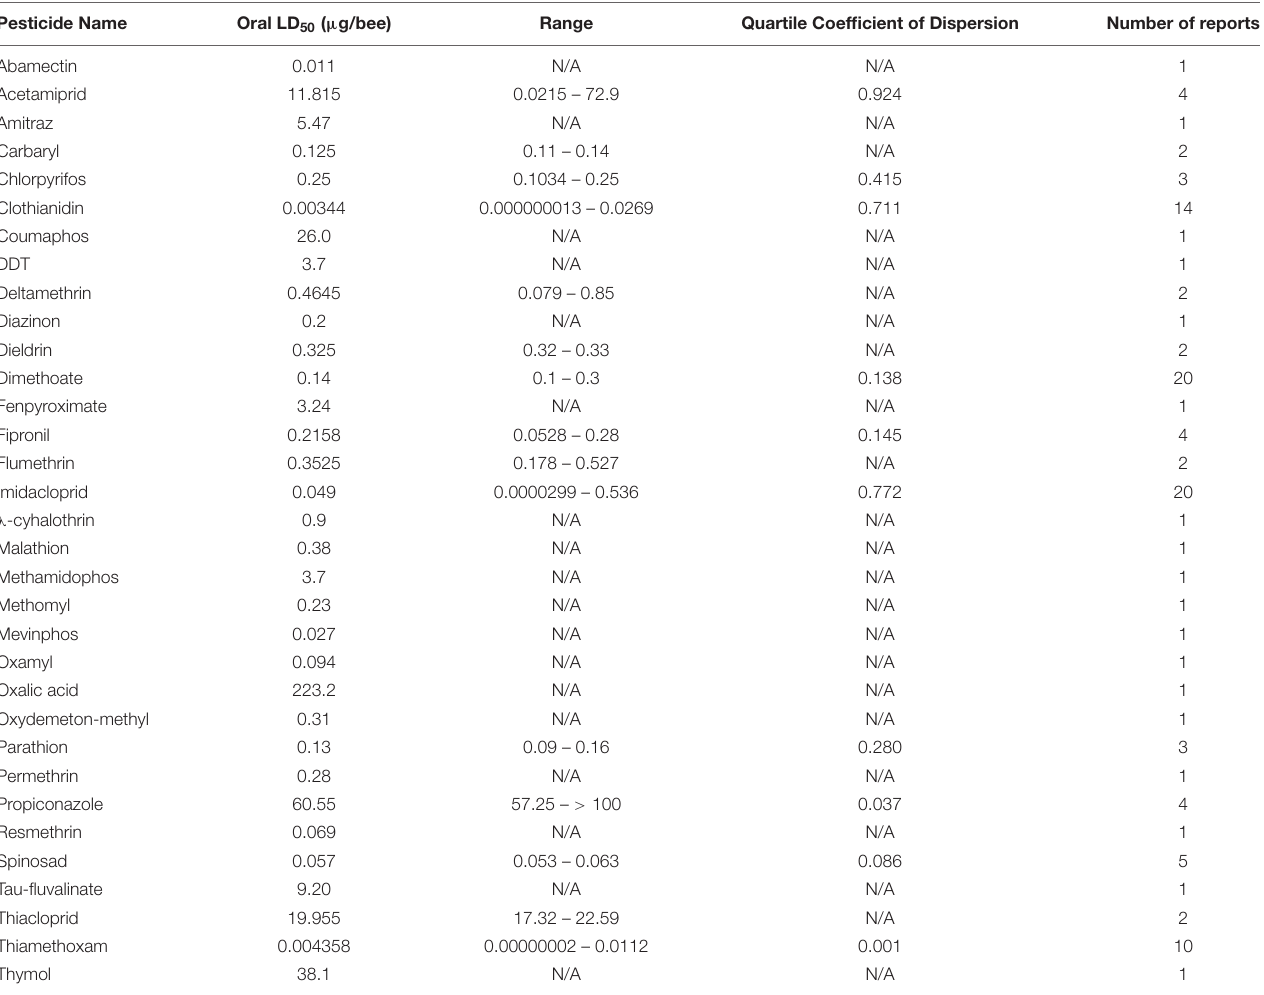
TABLE 2 | Range and median of reported oral LD 50 values of pesticides for adult honey